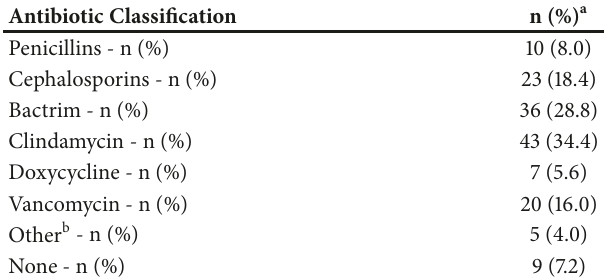
Table 3: Antibiotics administered in the ED. Antibiotic